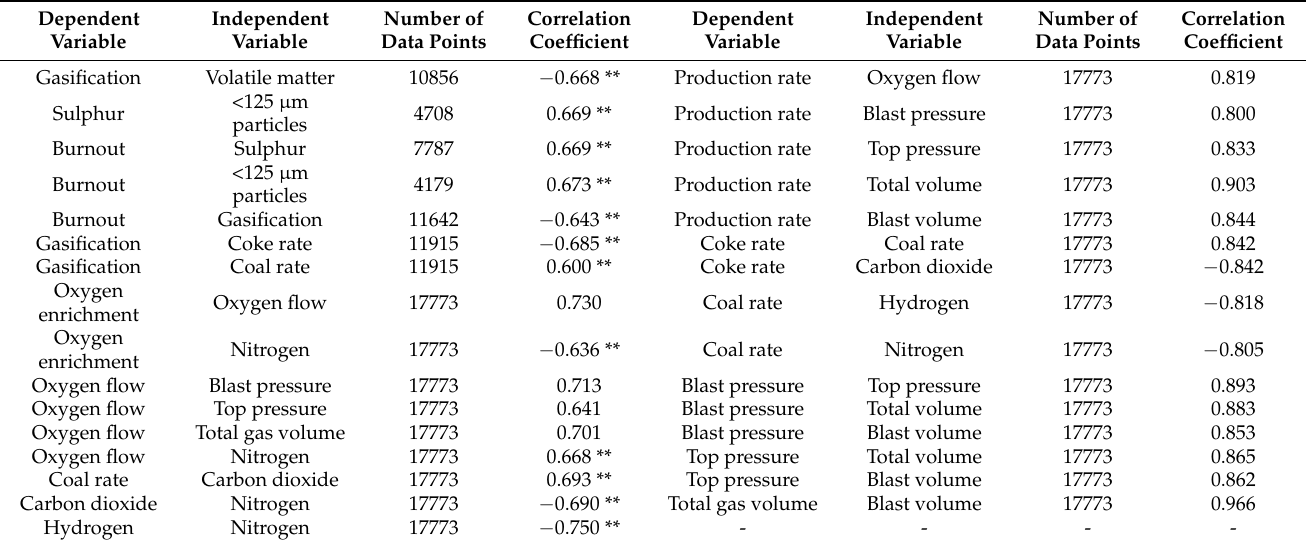
Figure 5. Scatter plot of the relationship between oxygen flow and the iron-production rate. Table 2. Spearman’s correlations of variables and